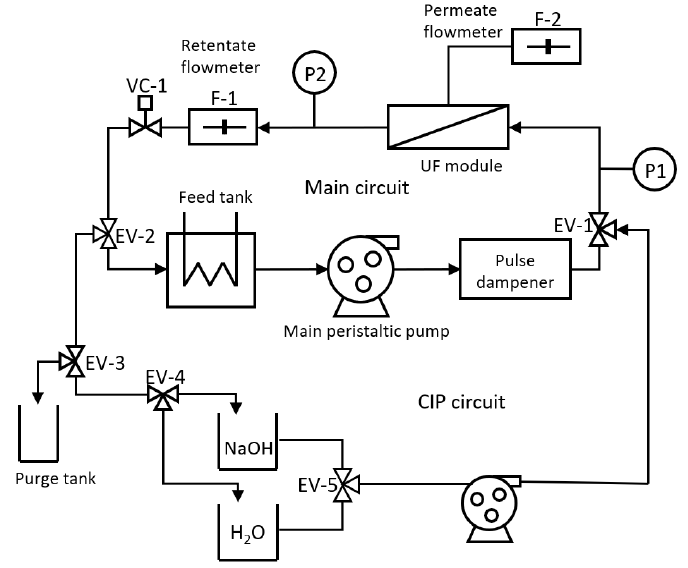
Figure 1. Schematic of the pilot